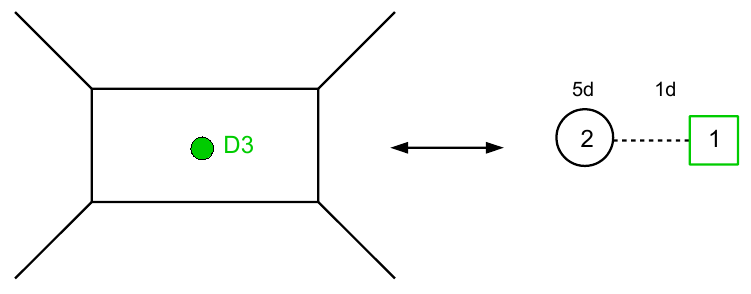
Figure 3 . 5d-1d quiver theory corresponding to the addition of a D3 brane in the center. The circle indicates the 1d (cid:13)avor symmetry gauged with 5d (cid:12)elds. The dashed line indicates a bifundamental Fermi multiplet (two